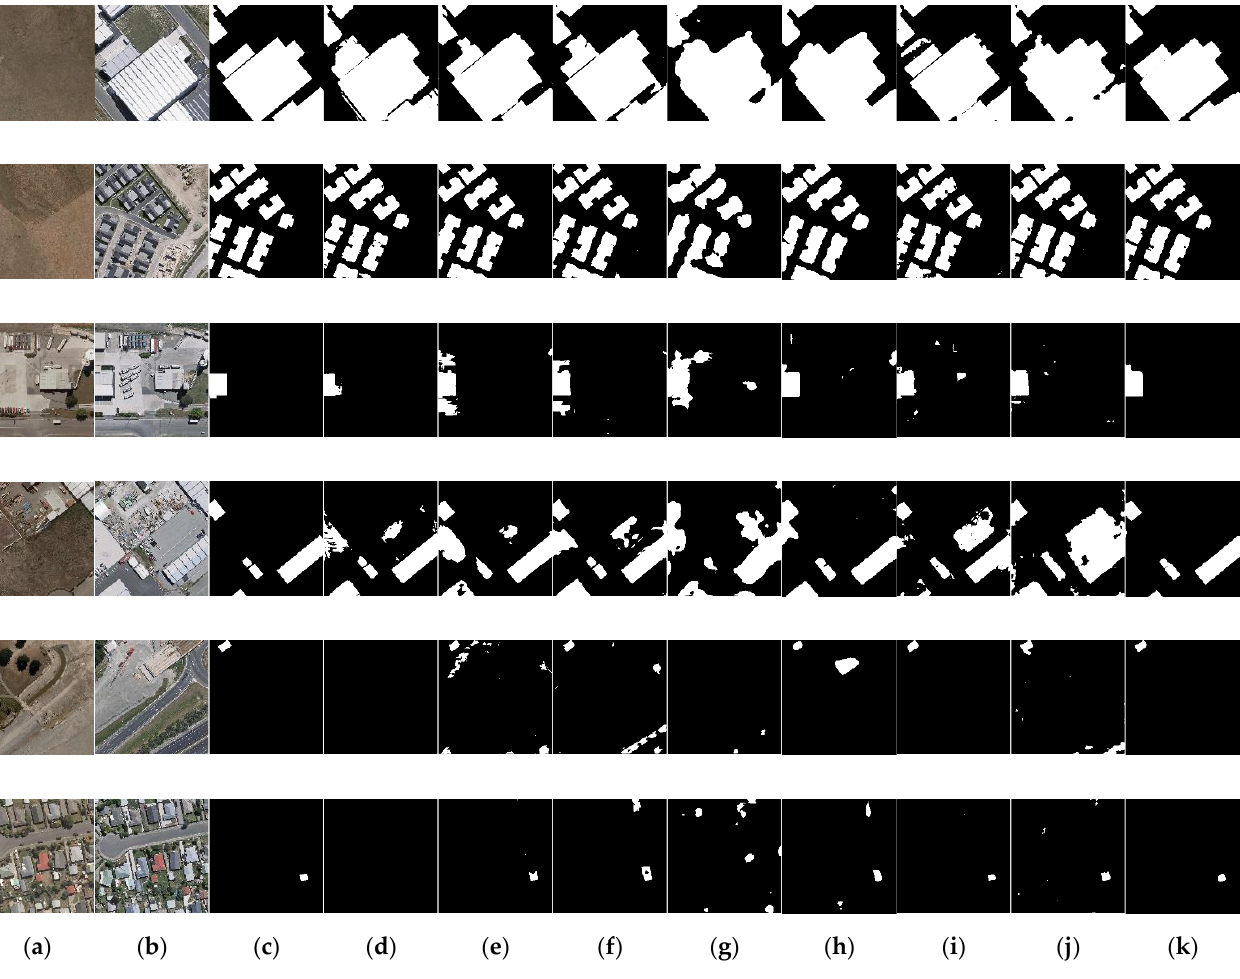
Figure 7. Visualized comparison of the results of several change detection methods on the BCDD dataset: ( a , b ) are bitemporal images; ( c ) is the ground truth; ( d ) FC-EF; ( e ) FC-Siam-conc; ( f ) FC-Siam-diff; ( g ) ChangeNet; ( h ) DASNet; ( i ) SNUNet-CD; ( j ) DTCDSCN(CD); ( k, ours ) MDESNet. Changed pixels are represented by white, whereas unchanged areas are shown in black.